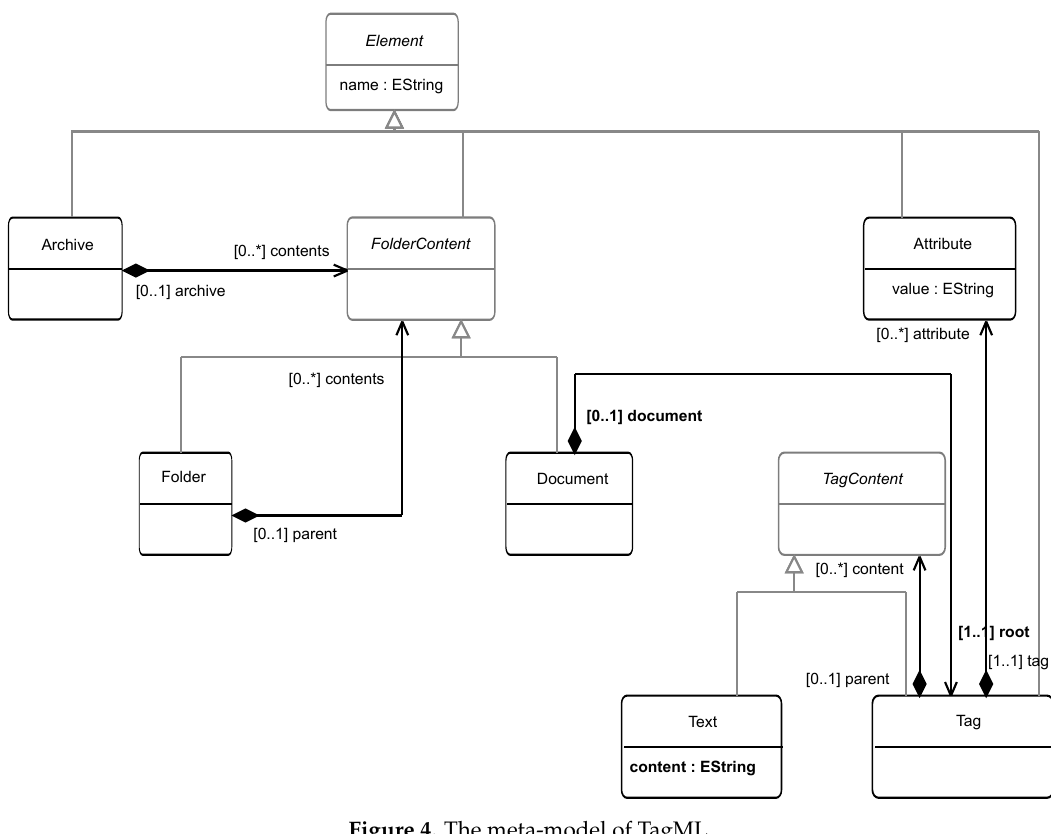
Figure 4. The meta-model of TagML.